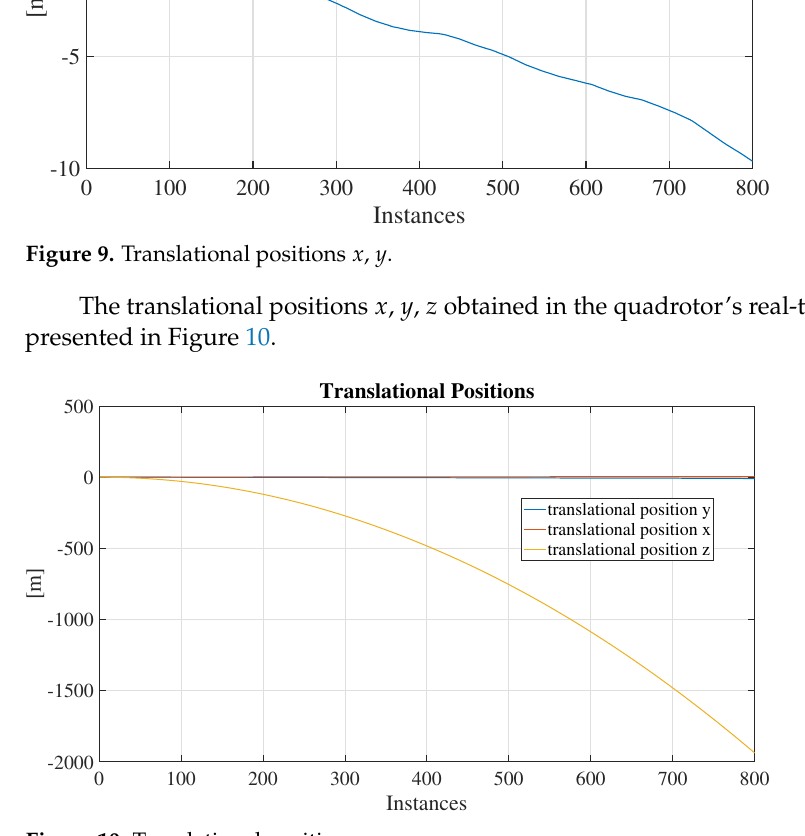
Figure 10. Translational positions x , y , z